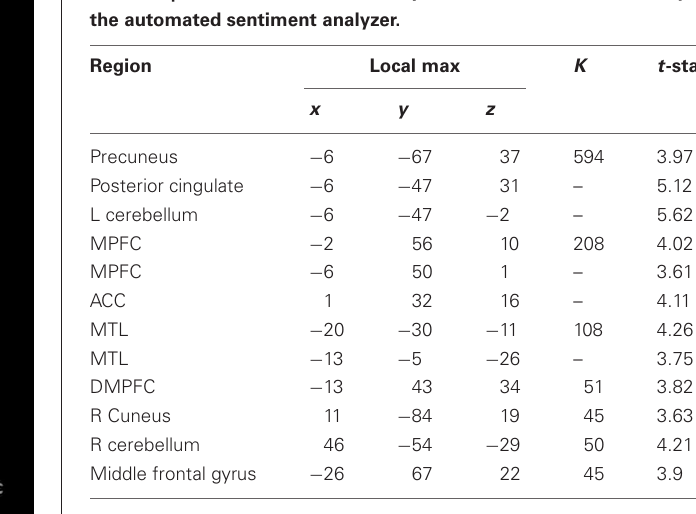
Table 3B | Positive correlations with positive sentiment, scaled by evaluative, as rated by the automated sentiment analyzer.